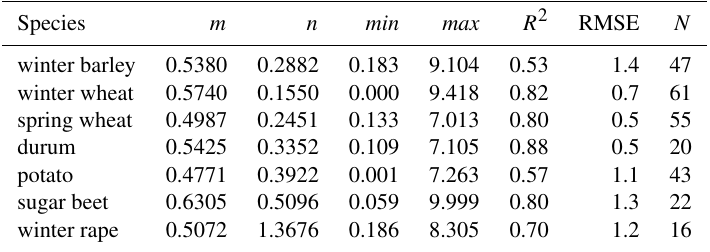
Table 3. Coefficients m and n of the linear calibration functions (Eq. 2) for the conversion of PAI CanEye into PAI estLAI2200 , correspond- ing range of PAI CanEye values involved in the calibration procedure, coefficients of determination (Pearson’s R 2 ), root mean square error (RMSE), and sample number ( N